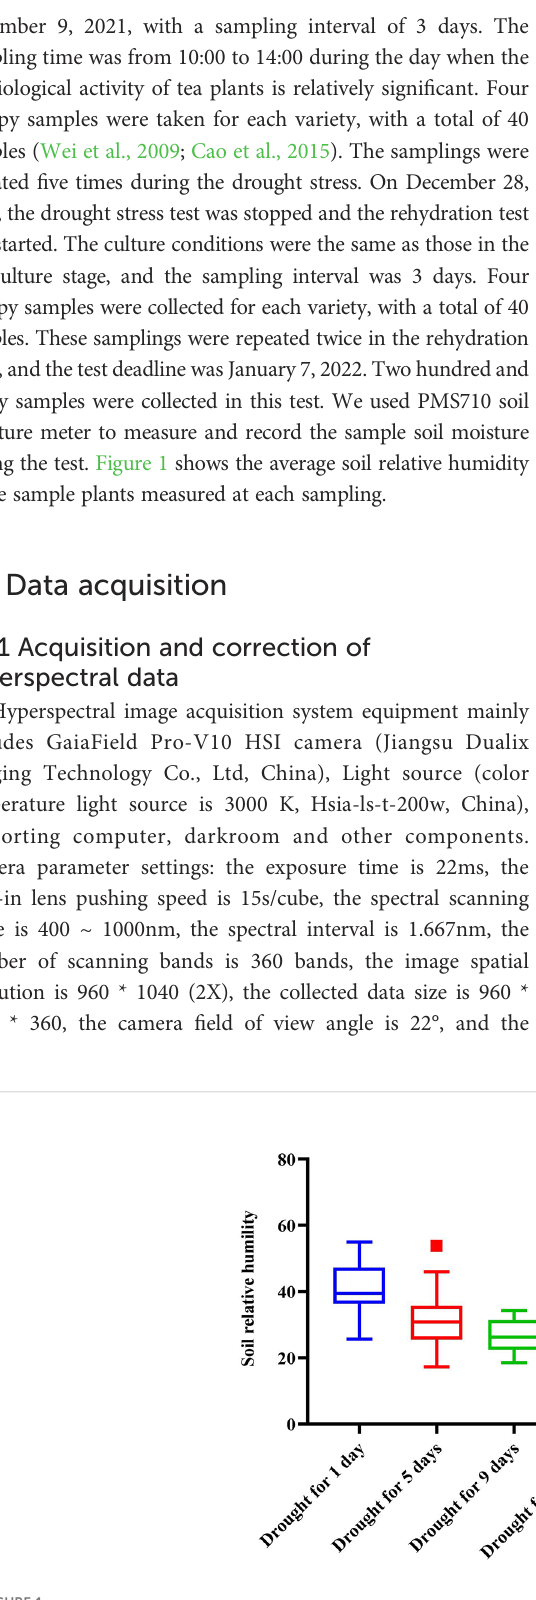
FIGURE 1 Value and trend of soil relative water content during the stress